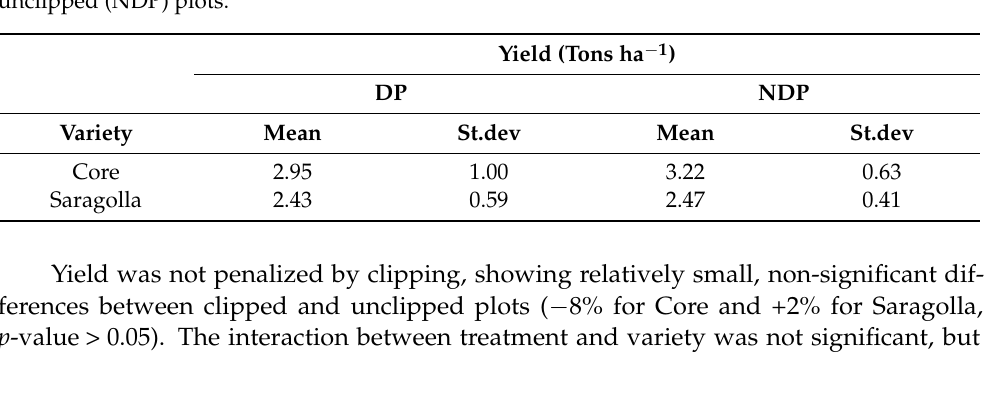
Table 1. Grain yield (t ha − 1 ) cultivars average values and standard deviation for clipped (DP) and unclipped (NDP)